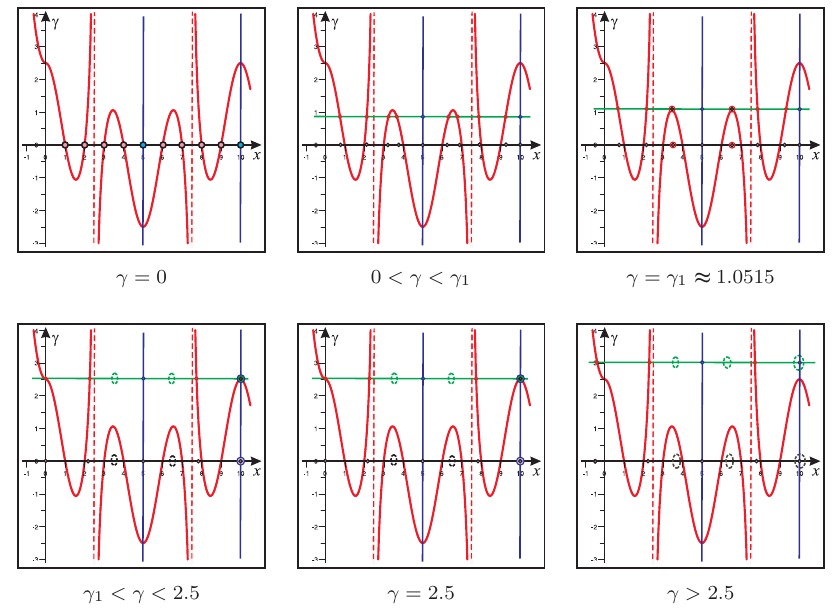
Figure 12. Generalized real characteristic functions γ ( xπ ; ξ ) for ξ = 2 / 5